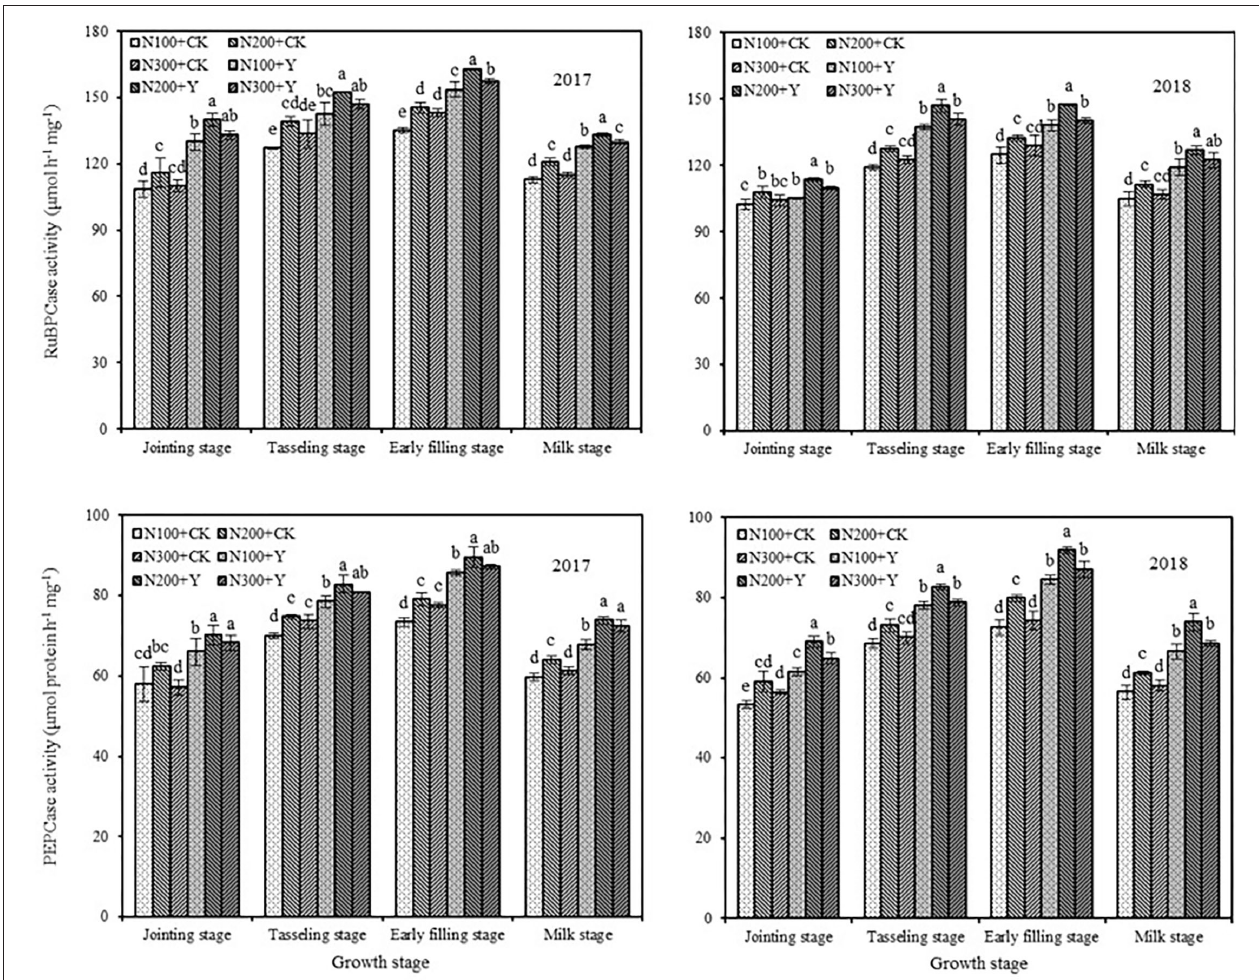
FIGURE 2 | Effects of chemical control and nitrogen fertilizers on RuBPCase and PEPCase activities in ear leaf during the maize growing period in 2017 and 2018. N100 + CK, N200 + CK, and N300 + CK indicate nitrogen applied levels at 100, 200, and 300kg ha − 1 under water treatment, respectively; N100 + Y, N200 + Y,